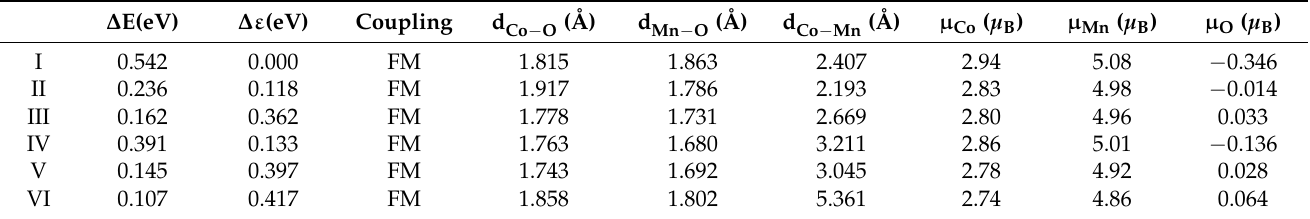
Figure 3. DOS and PDOS plots of ZnO nanowires: ( a ) pure TDOS, ( b ) Mn/Co co − doped TDOS, ( c ) pure PDOS of Zn atoms, ( d ) pure PDOS of O atoms. Table 1. Energies, bond lengths, magnetic moments, and magnetic coupling states of Co/Mn co- doped ZnO nanowires.